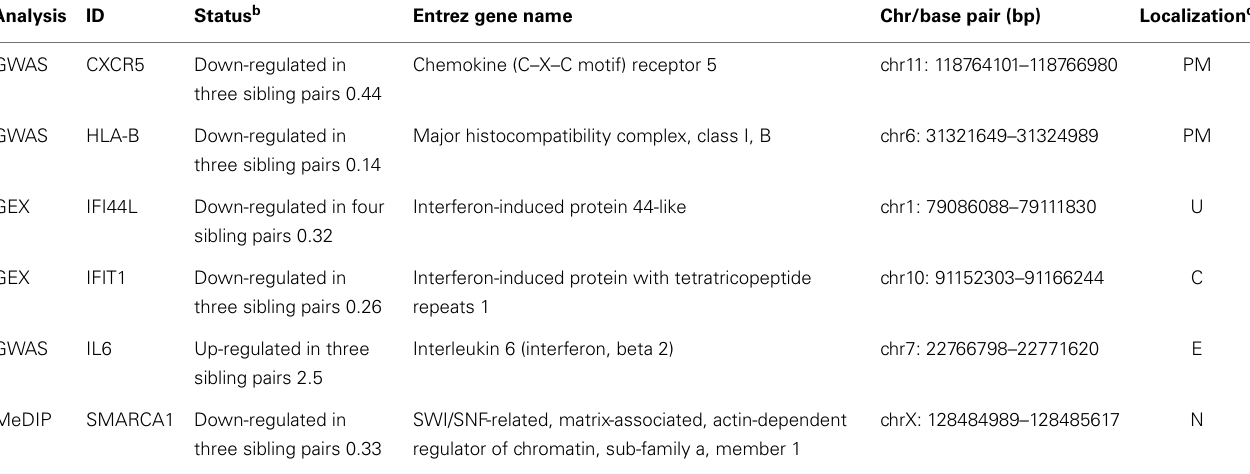
Table 3 | Genes showing consistent differences in DNA methylation, CNV, or expression a